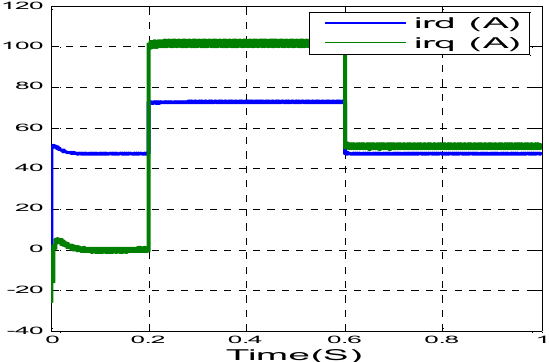
Figure 16. Direct currents and rotor quadrature.